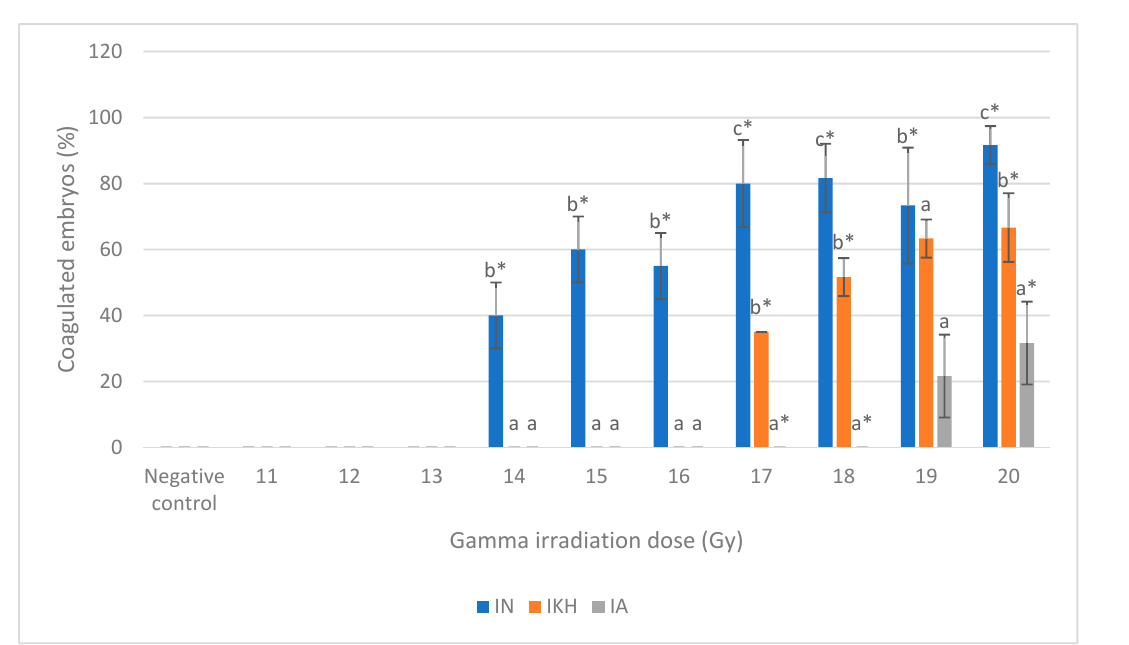
Figure 3. Total coagulated zebrafish embryos in IN, IKH and IA group. a*, b* and c* indicate significant difference ( p < 0.05) compared to other treatment groups. a indicates no significant difference ( p > 0.05) compared to other treatment